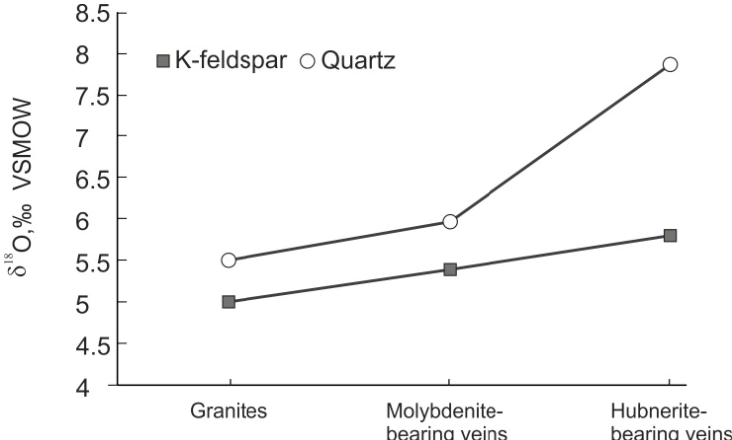
Figure 4. Evolution of δ 18 O values in quartz and K-feldspar from granites in the Pervomaika massif molybdenite-bearing veins and hubnerite-bearing veins.